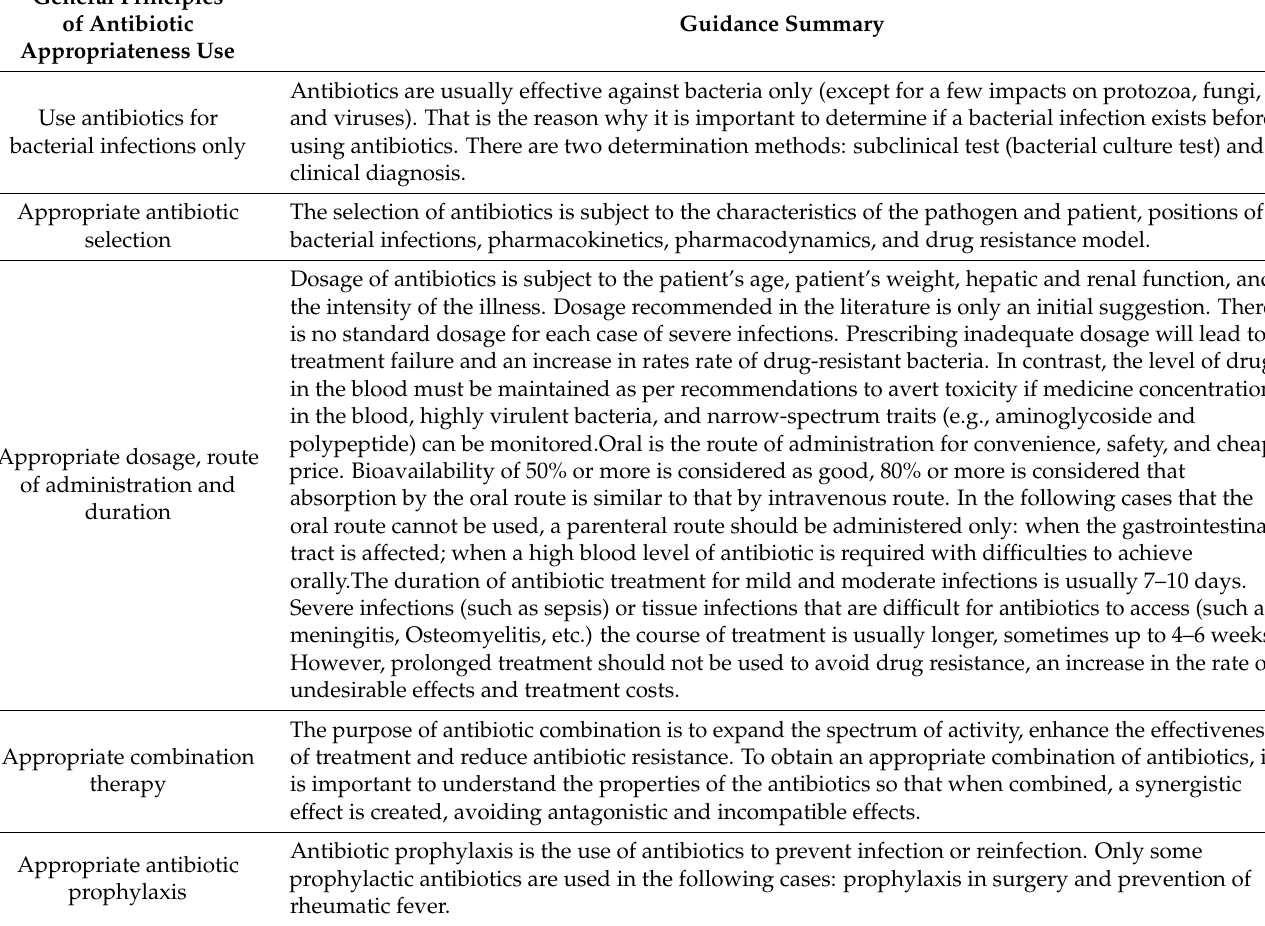
Table A1. General principles for appropriate antibiotic use according to Vietnam’s Ministry of Health.